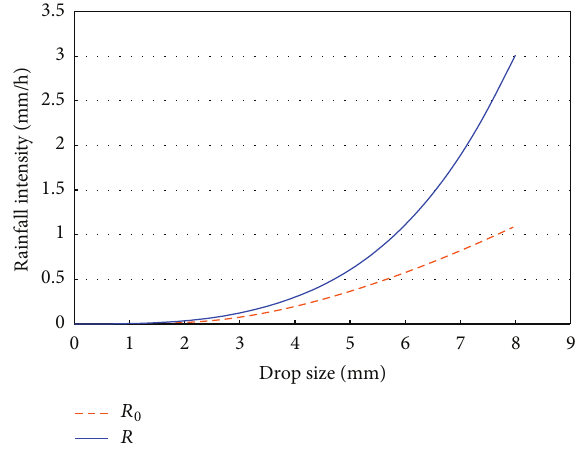
Figure 5: Rainfall intensities calculated with the sampling area uncorrected ( 𝑅 0 ) and corrected ( 𝑅